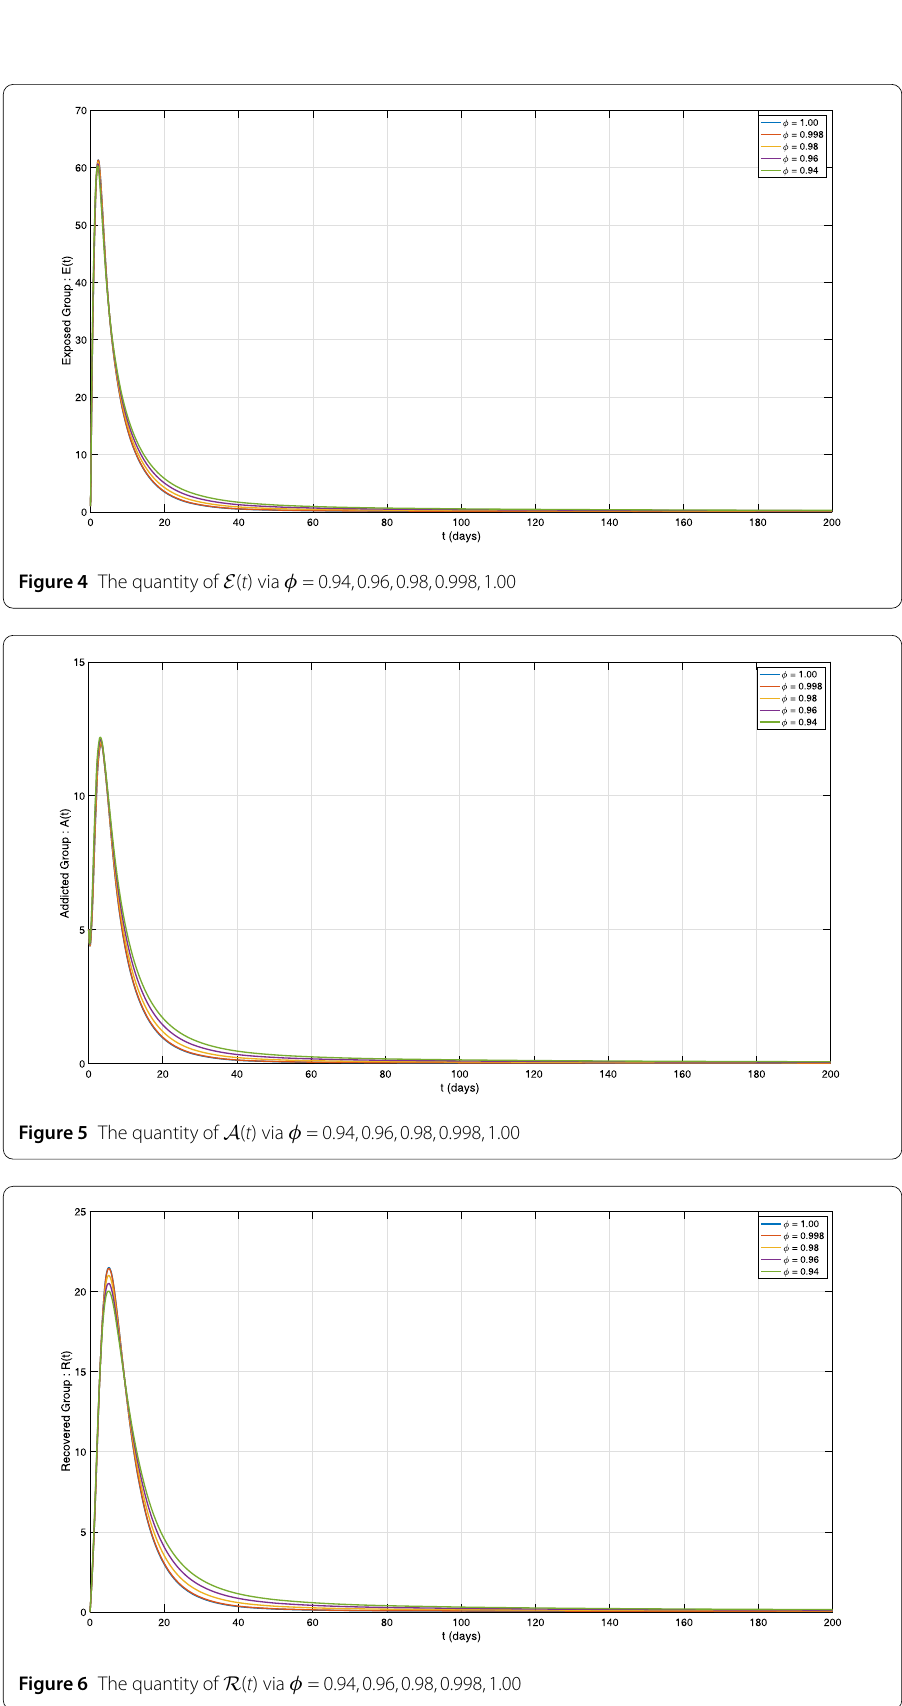
Figure 6 The quantity of R ( t ) via φ =